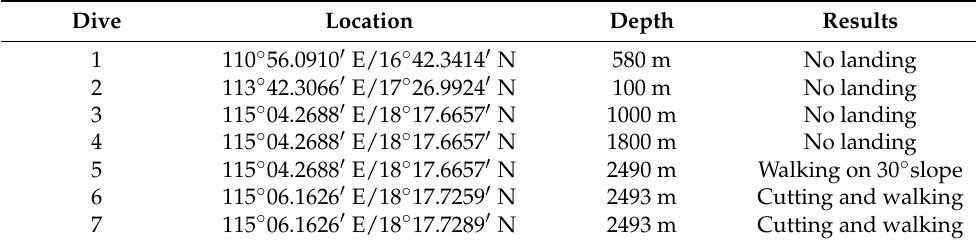
Table 11. Overview of the launches.